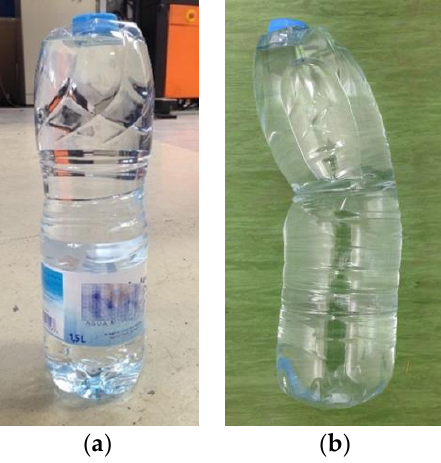
Figure 7. Residual deformations with tests ending before ( a ) and after buckling ( b ).